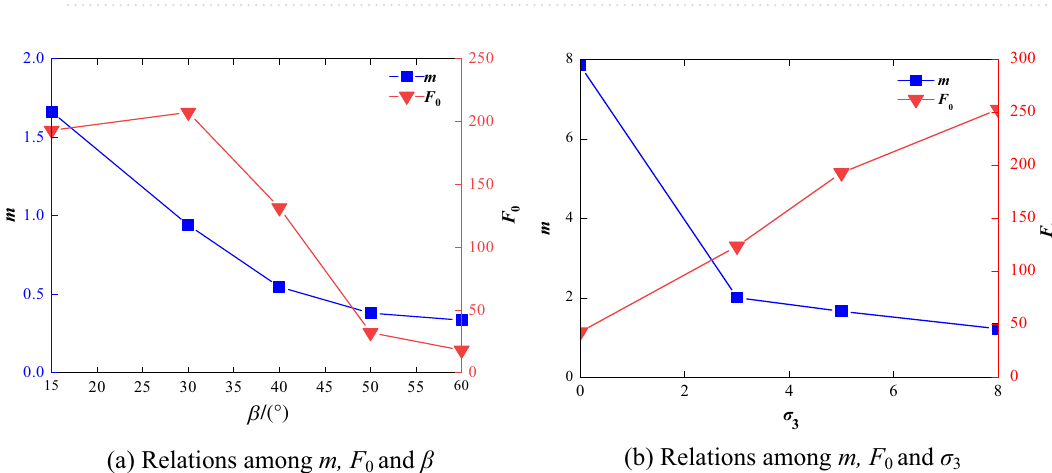
Figure 3. Effect of model parameters on the shape of model curves.